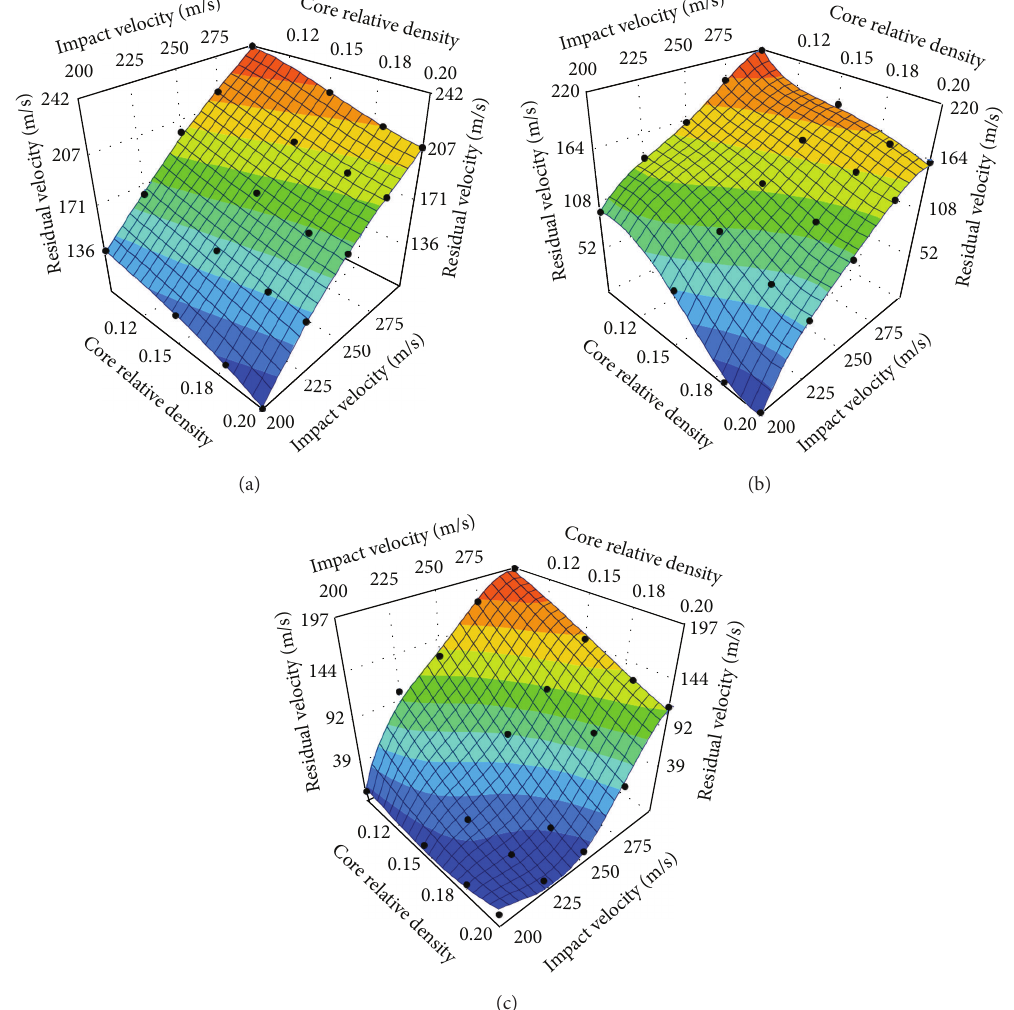
Figure 16: Quartic polynomial approximations of the residual velocity of projectile impact on auxetic HSPs with different core relative densities. The bold black dots in the plots show the training points. (a) 𝑇 𝑐 = 30 mm, (b) 𝑇 𝑐 = 50 mm, and (c) 𝑇 𝑐 = 70 mm ( 𝑇 𝑓 = 1.0